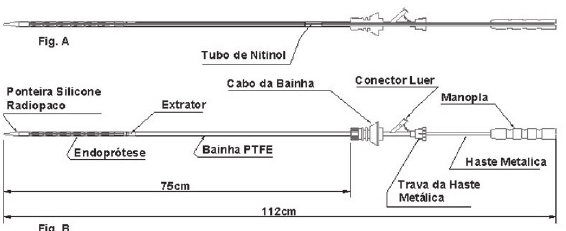
Fig. 1 - Esquema do dispositivo introdutor de stent aórtico auto-expansível A. Corte longitudinal do dispositivo introdutor, mostrando tubo de nitinol sobre o qual todo o dispositivo é montado e pelo qual se passa o fio-guia de 0,035mm ou 0,032mm extraduro.